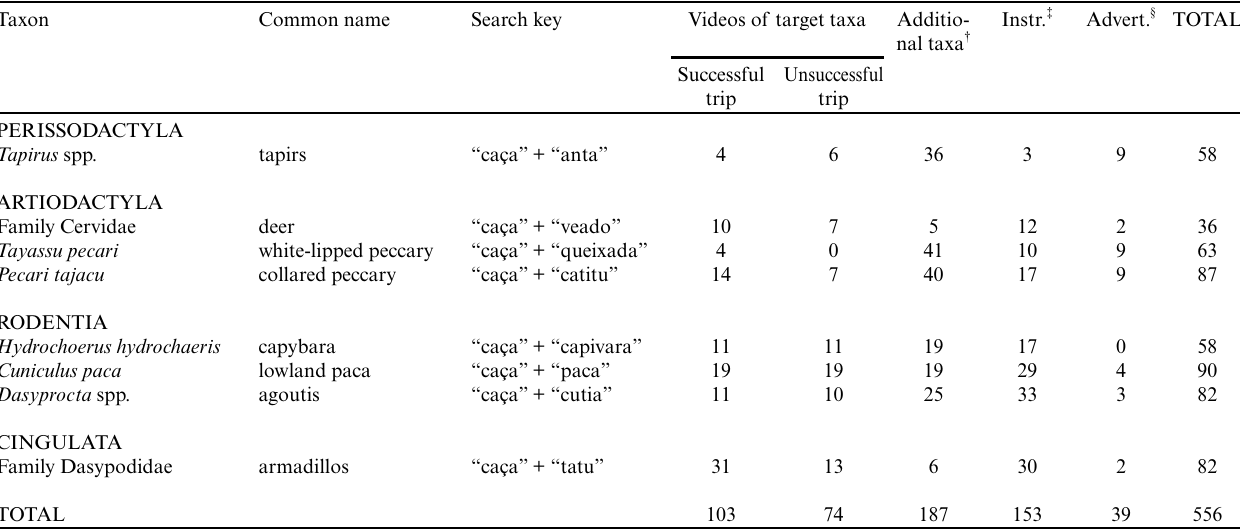
Table 1 . The eight mammalian taxa most often cited as hunting targets in Brazil, the search keys created to find Brazilian sport hunting videos posted on Youtube™, and the number of videos found over the results pages for each search key. Taxon Common name Search key Videos of target taxa Additio­